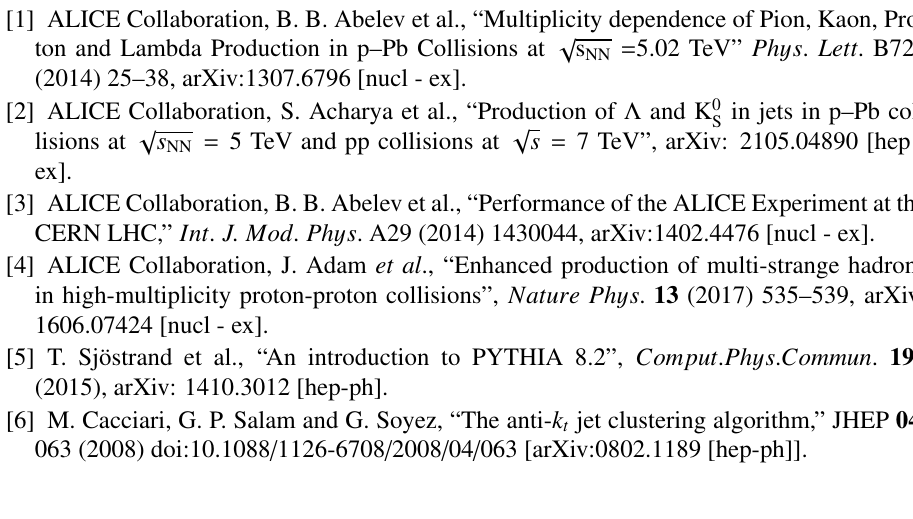
Figure 3. (color online) The ( Ξ − + Ξ PYTHIA 8